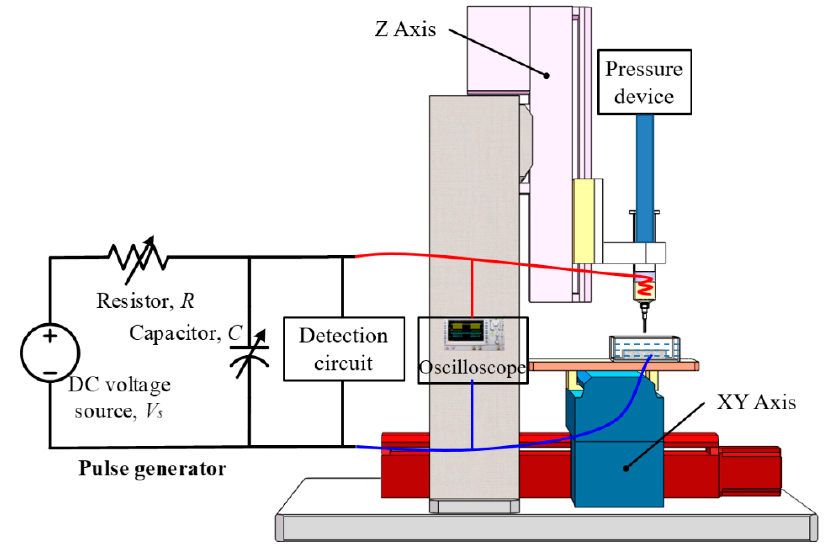
Figure 9. Experimental set-up for liquid-metal electrode μ EDM.